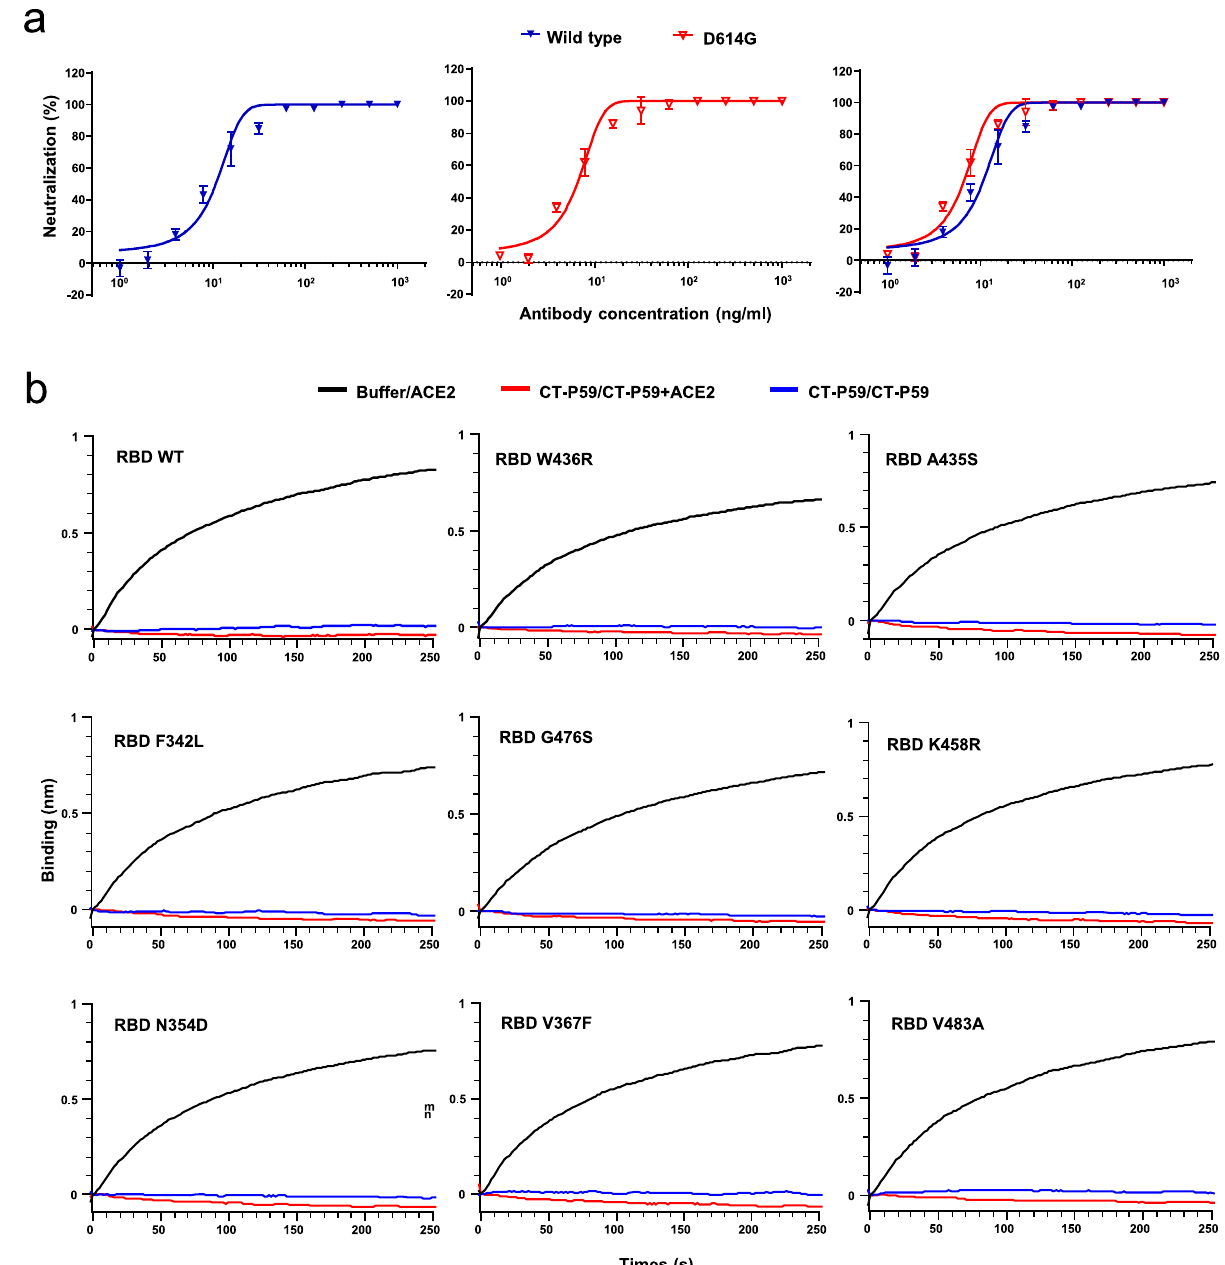
Fig. 1 CT-P59 can effectively neutralize SARS-CoV-2 in vitro by blocking RBD-ACE2 binding. a Serial twofold-diluted CT-P59 were incubated with SARS- CoV-2 live viruses; wild type (blue) and D614G (red). The mixture was added to VeroE6 cells. After 2 – 3 days of incubation, the neutralization activity was evaluated by counting plaques. Two independent experiments were performed in duplicate. b SARS-CoV-2 RBD immobilized on biosensor was saturated with CT-P59. Then, CT-P59 fl owed over the biosensor surface in the presence (red) or absence (blue) of the ACE2 receptor. As a positive control, the buffer was loaded onto SARS-CoV-2 RBD immobilized biosensor, and ACE2 fl owed over the biosensor surface